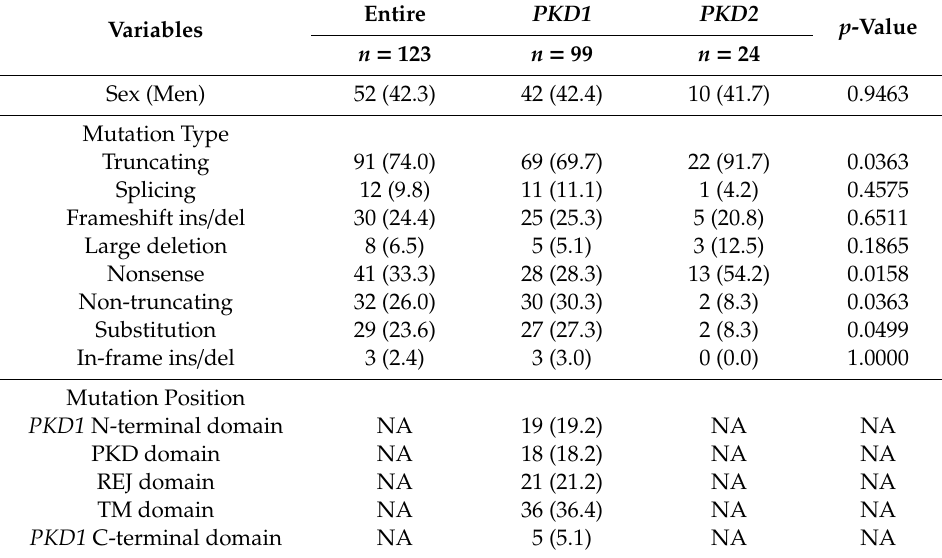
Table 1. Patient